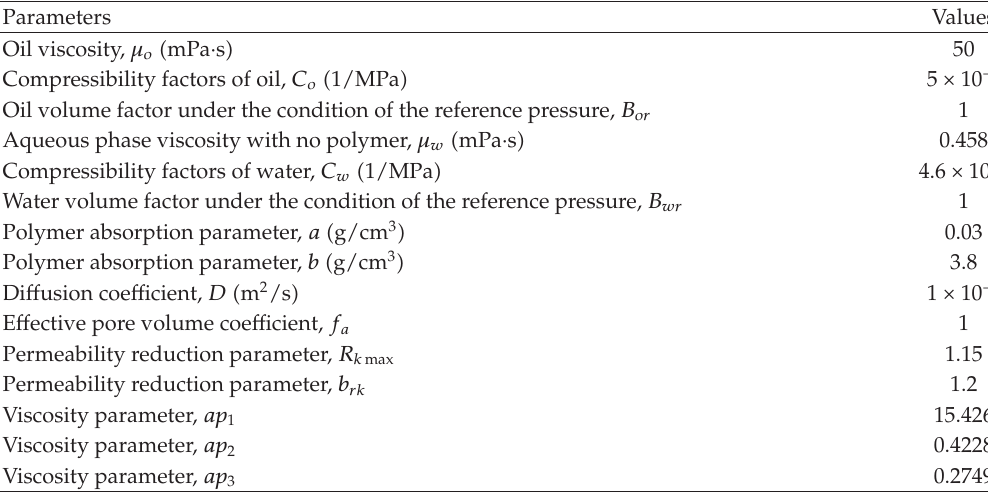
Table 2: Fluid data used in the